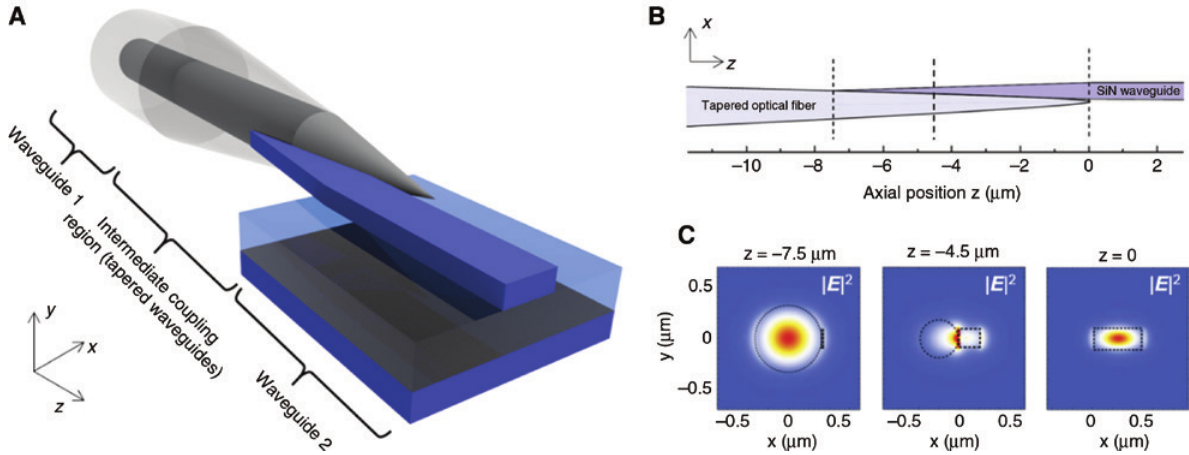
Figure 12: (A) Schematic diagram of the fiber-waveguide coupling scheme. (B) Adiabatic coupling between high-index SiN waveguide (right) and low-index tapered optical fiber (left). (C) The corresponding cross-sectional of | E | 2 obtained from the FDTD simulations at various positions along the adiabatic